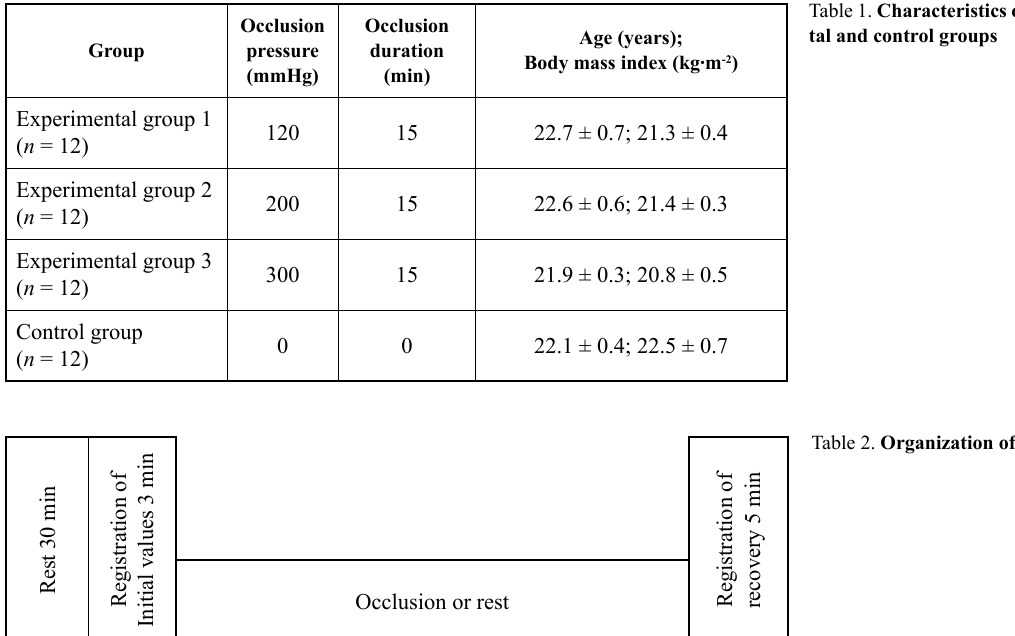
Table 2. Organization of the